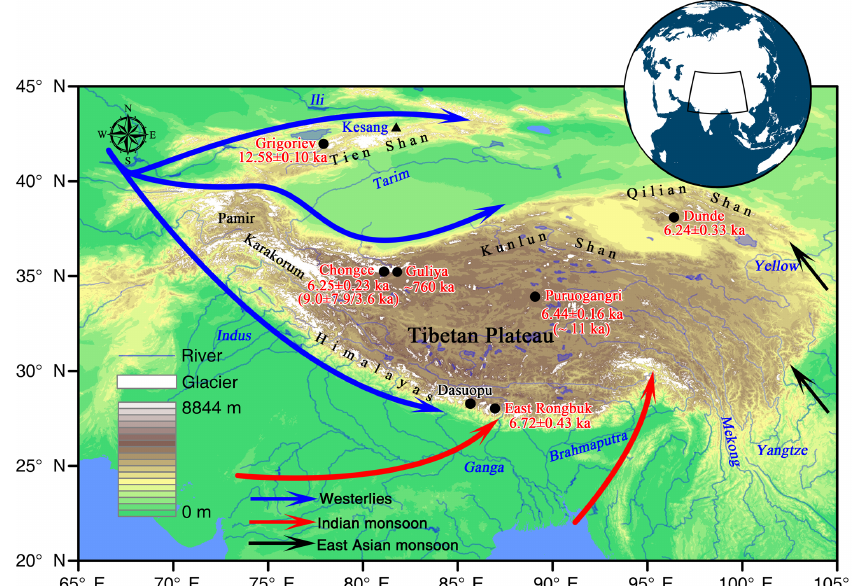
Figure 1. Map showing the locations of ice core drilling sites. The numbers for each site except Guliya are the oldest-measured 14 C ages, while the number inside the bracket below the Chongce site is the estimated ice age at the ice–bedrock interface. The schematic positions of the westerlies and the monsoon circulations are from Yao et al. (2013). Data on glaciers are from the Global Land Ice Measurements from Space (GLIMS, available at http://www.glims.org, last access: 13 July 2018). The topographic data were extracted using ETOPO1 elevations global data, available from National Oceanic and Atmospheric Administration at http://www.ngdc.noaa.gov/mgg/global/global.html (last access: 13 July